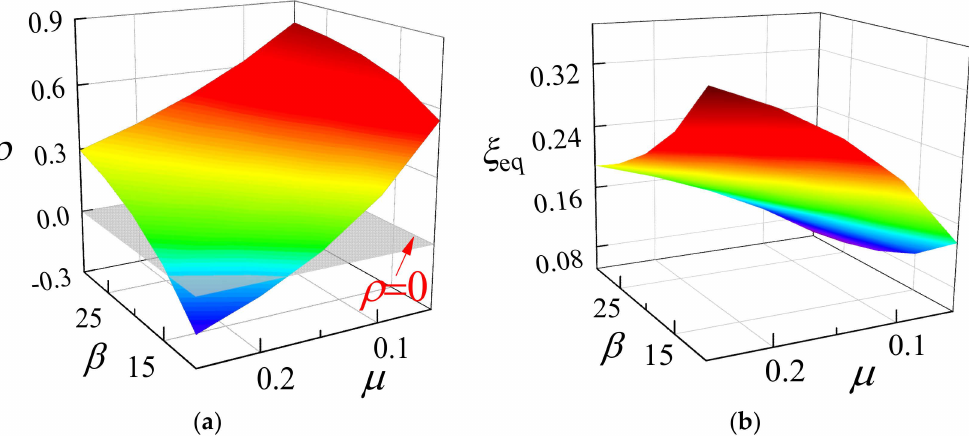
Figure 12. Effects of µ and β on self-centering coefficient and damping performance: ( a ) ρ ; ( b ) ξ eq